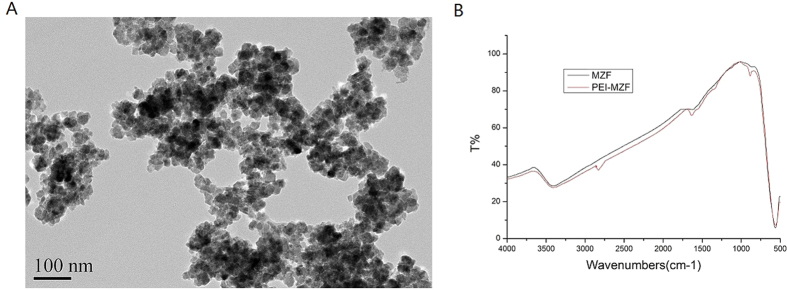
TEM examination of Mn0.5Zn0.5Fe2O4 nanoparticles (MZF-NPs) and the infrared spectrum analysis to detect PEI-modified MZF-NPs.(A) TEM image of MZF-NPs; (B) The infrared spectrum analysis.